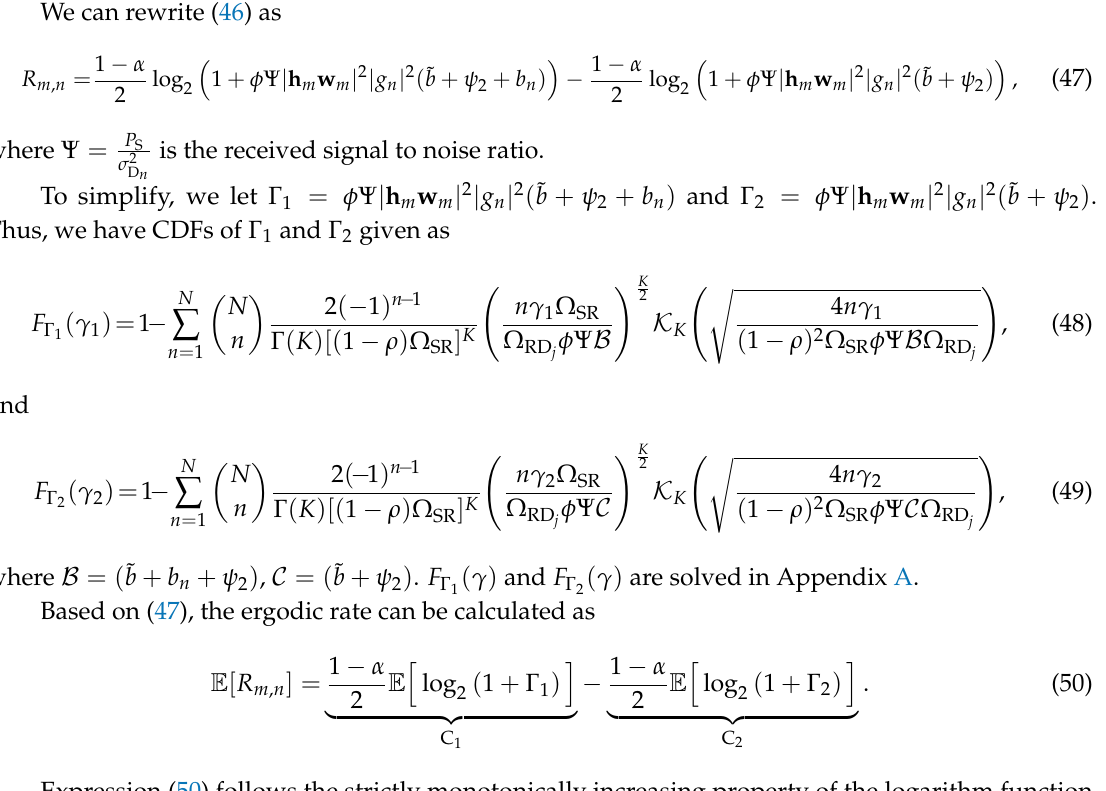
Figure 4. The comparison between CDF of γ SR and CDF of γ